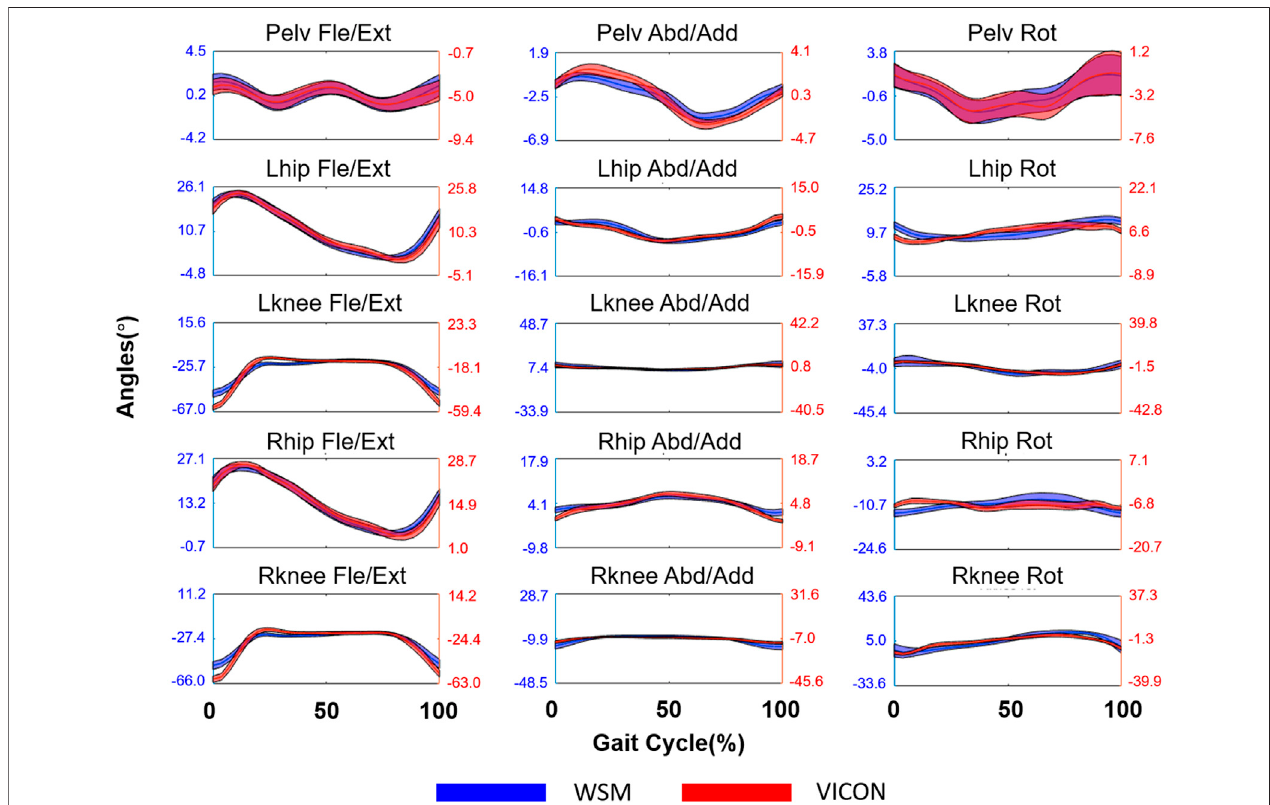
FIGURE 11 | Joint-angle estimation results for the lower limbs of a human subject walking on a treadmill. The blue and red lines respectively denote the WSM and infrared camera-based systems (VICON). The X axis denotes the gait cycle percentage (%), and the Y axis denotes the estimated joint angle in degrees ( ° ), which was averaged over all gait